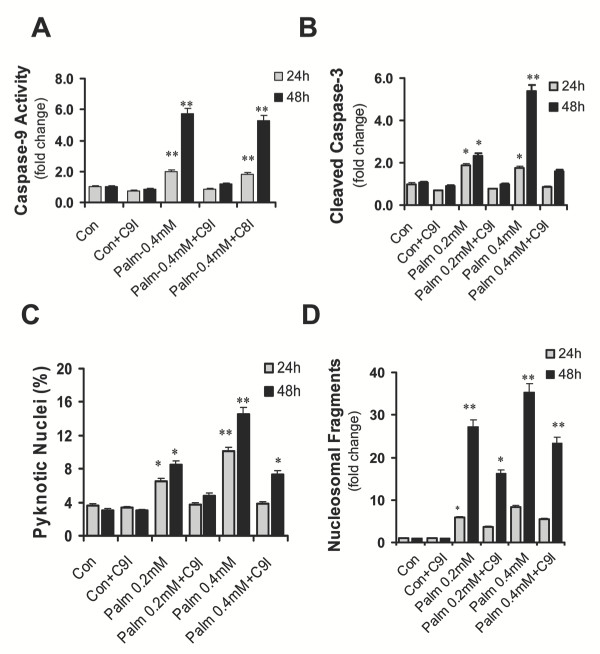
Effect of caspase 9 inhibition on apoptosis of HMC induced by palmitate. (A) Cells were treated with control (Con) or palmitate (Palm) in the presence and absence of the cell permeable caspase 9 inhibitor (C9I, Z-LEHD-FMK) or the caspase 8 inhibitor (C8I, Z-IETD-FMK), both at 40 μM. Addition of the caspase inhibitors was concurrent with addition of the FFA. After 24 and 48 h, caspase 9 enzyme activity was measured and expressed as fold-change over control. (B) Palmitate and Z-LEHD-FMK were added to HMC as above, and cleavage of caspase-3 was measured by ELISA as described in Experimental Procedures. (C) The number of pyknotic nuclei was assessed in cells treated with palmitate with and without Z-LEHD-FMK. (D) DNA fragmentation, assessed by ELISA as the number of nucleosomal fragments in the cytosol, was measured in cells treated with palmitate and by Z-LEHD-FMK. For A-D, data are mean ± SEM for 3 independent experiments. **, P < 0.01, *, P < 0.05 versus control by ANOVA in (A, B and D) or Chi-square test in (C).